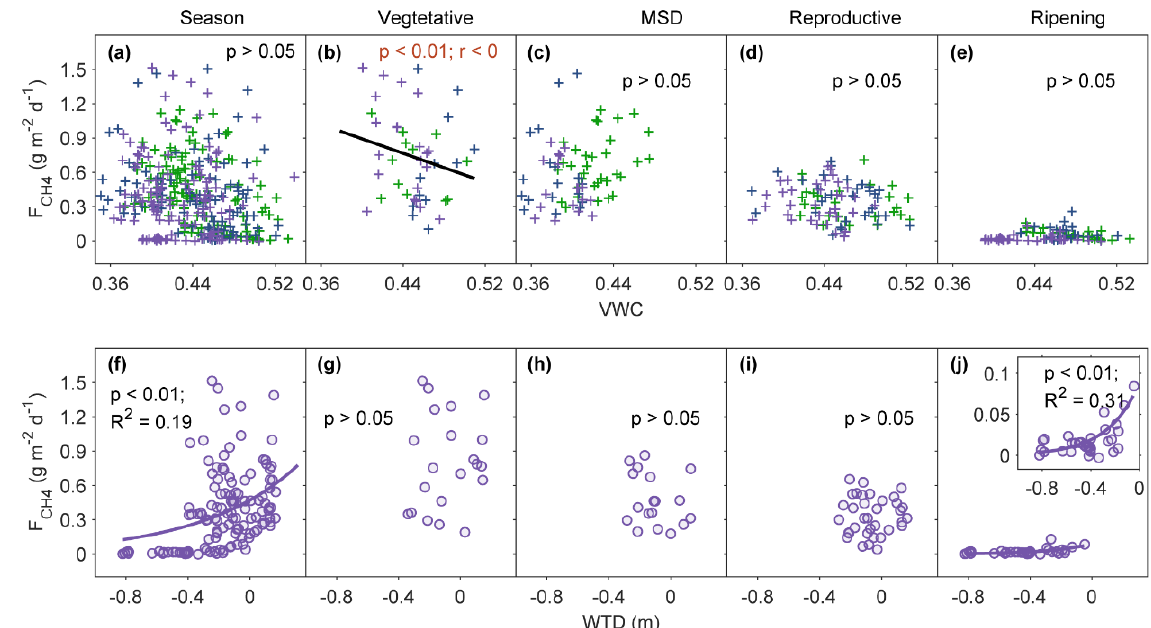
Figure 5. The relationship between daily CH 4 fluxes and volumetric water content (VWC, ( a – e )) in 2016 (green), 2017 (blue) and 2018 (purple), water table depth (WTD, ( f – j )) in 2018 (purple) over the whole rice season ( a , f ), during the vegetative stage ( b , g ), during the mid-season drainage periods ( c , h ), during the reproductive stage ( d , i ), during the ripening stage ( e , j ). Daily CH 4 fluxes and VWC showed a significant negative correlation only during the vegetative stage ( b ). Daily CH 4 fluxes and WTD showed a significant positive correlation for the whole season ( f ) and during the ripening stage when WTD was very low ( j